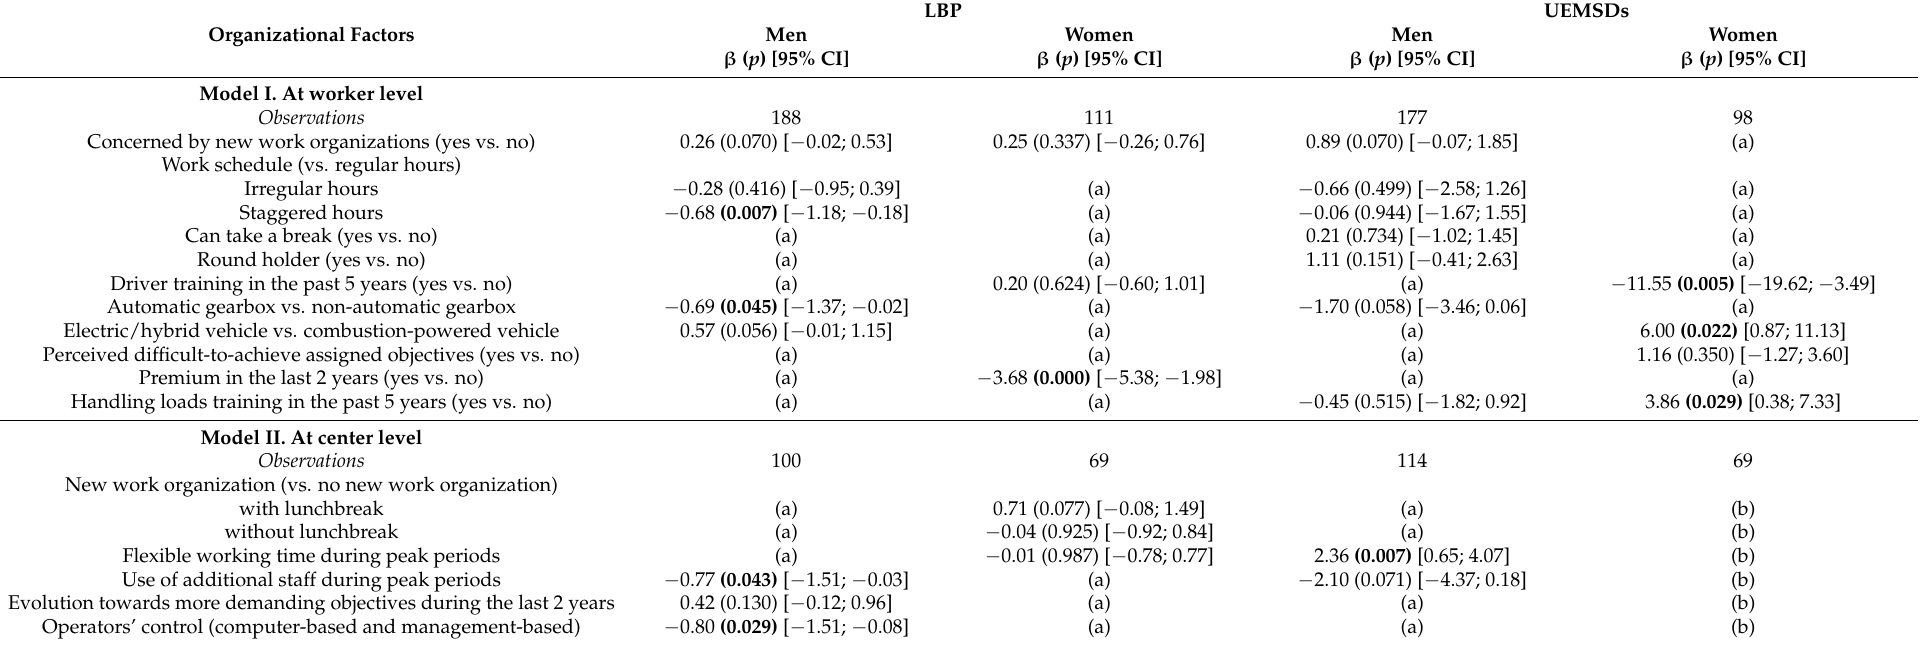
Table 6. Selected organizational factors associated with low back pain (LBP) and clinically diagnosed upper-extremity musculoskeletal disorders (UEMSDs) in workers driving a light-duty vehicle (LDV), expressed by a regression coefficient β ( p -value) [95% confidence interval] in models adjusted for personal factors and work constraints. A positive coefficient indicates a risk factor and a negative one indicates a potentially protective factor; bold figures indicate statistically significant p < 0.05; (a), organizational factors not selected in the stepwise procedure; (b), model